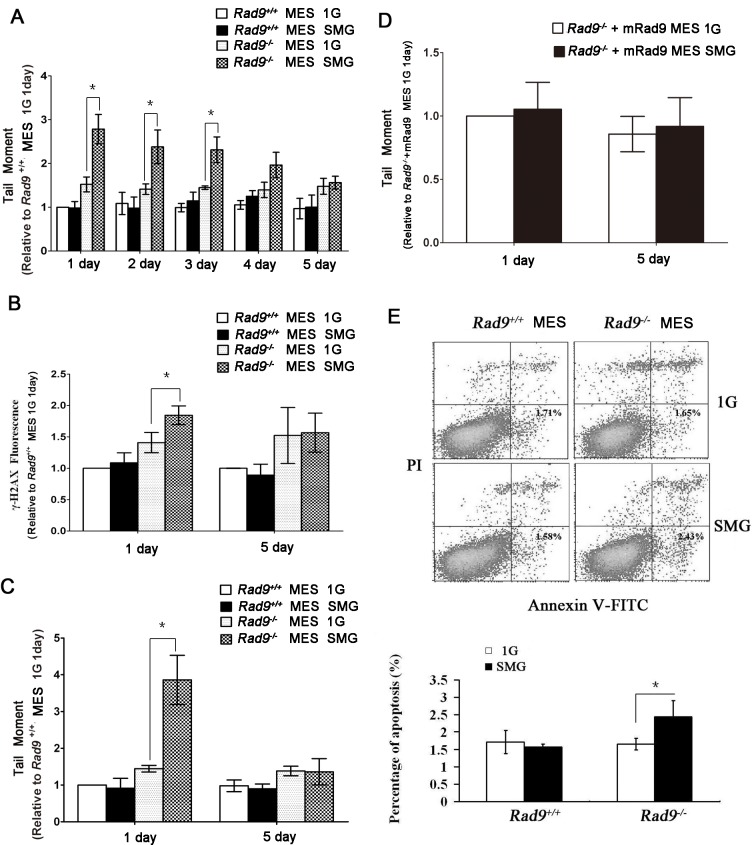
Effects of SMG on DNA damage and apoptosis in Rad9
+/+ and Rad9
-/- MES cells.(A) Evaluation of DNA double strand break by neutral comet assay in Rad9
+/+ and Rad9
-/- MES cells cultured under 1G or SMG condition. Time points were 1, 2, 3, 4 and 5 days. At least 50 cells for each condition were scored for comet tail moment. (B) Flow cytometric analysis of γ-H2AX formation in Rad9
+/+ and Rad9
-/- mMES cells cultured under 1G or SMG condition for 1 or 5 days. (C) Evaluation of DNA damage by alkaline comet assay in Rad9
+/+ and Rad9
-/- MES cells cultured under 1G or SMG condition for 1 or 5 days. At least 50 cells for each condition were scored for comet tail moment. (D) Evaluation of DNA damage by alkaline comet assay in Rad9
-/- MES cells with ectopic expression of Rad9 (Rad9
-/-
+Rad9 MES cells) cultured under 1G or SMG condition for 1 or 5 days. At least 50 cells for each condition were scored for comet tail moment. (E) Flow cytometric analysis of Rad9
+/+ and Rad9
-/- MES cells cultured under 1G or SMG condition for 1 day to assess apoptosis using Annexin V labeling. Experiments were performed three times and representative analyses are shown (upper). The lower part is the quantitative comparison of apoptosis between the 1G Group and the SMG Group. The data represent mean ± SD of at least three independent experiments. Student’s t test, *P<0.05.